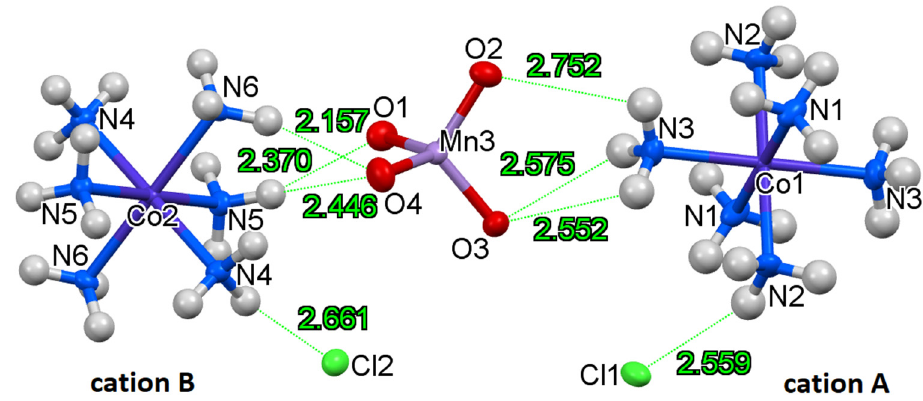
Figure 1. Hydrogen bond interactions and atom labeling in the structure of hexaamminecobalt (III) dichloro permanganate (atomic displacement parameters are drawn at the probability level of 50%).